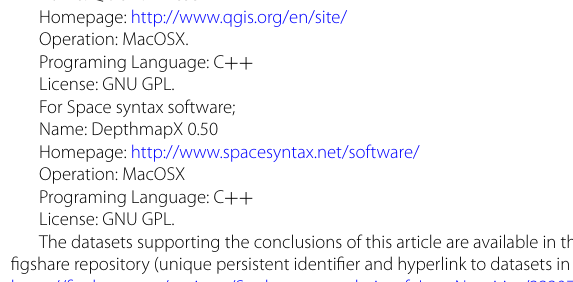
figshare repository (unique persistent identifier and hyperlink to datasets in